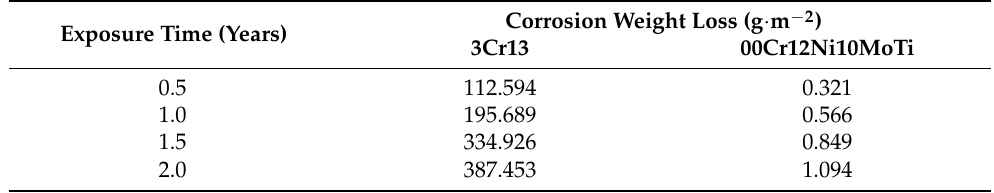
Figure 2. TEM photo of 00Cr12Ni10MoTi maraging stainless steel aged at 510 °C for 4 h: ( a ) bright- field image, ( b ) dark-field image taken from the diffraction spot indicated by an arrow in ( c ) show- ing precipitates, ( c ) selected area diffraction pattern with zone axis (cid:4670)011(cid:4671) (cid:2961)(cid:4593) , ( d ) schematics of se- lected area diffraction pattern with zone axis (cid:4670)011(cid:4671) (cid:2961)(cid:4593) .